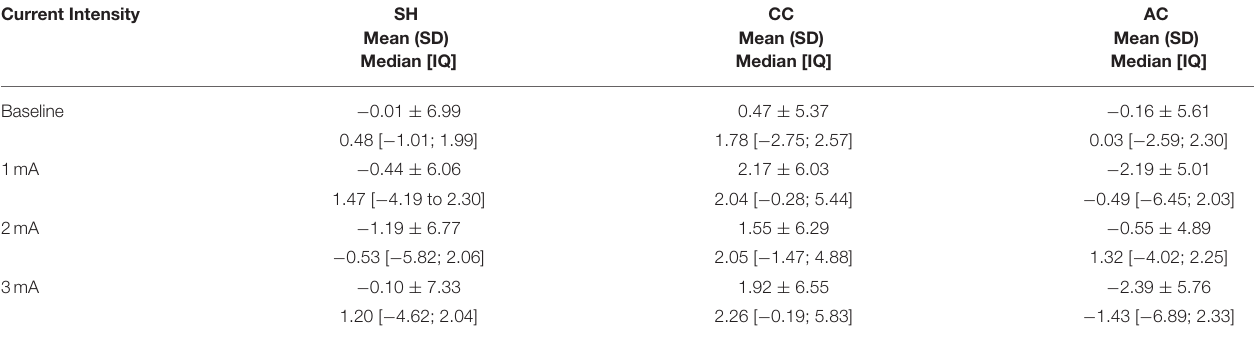
TABLE 3 | Descriptive data of weight-bearing asymmetry (WBA) for each HD-tDCS 3 × 1 condition and current intensity. Current